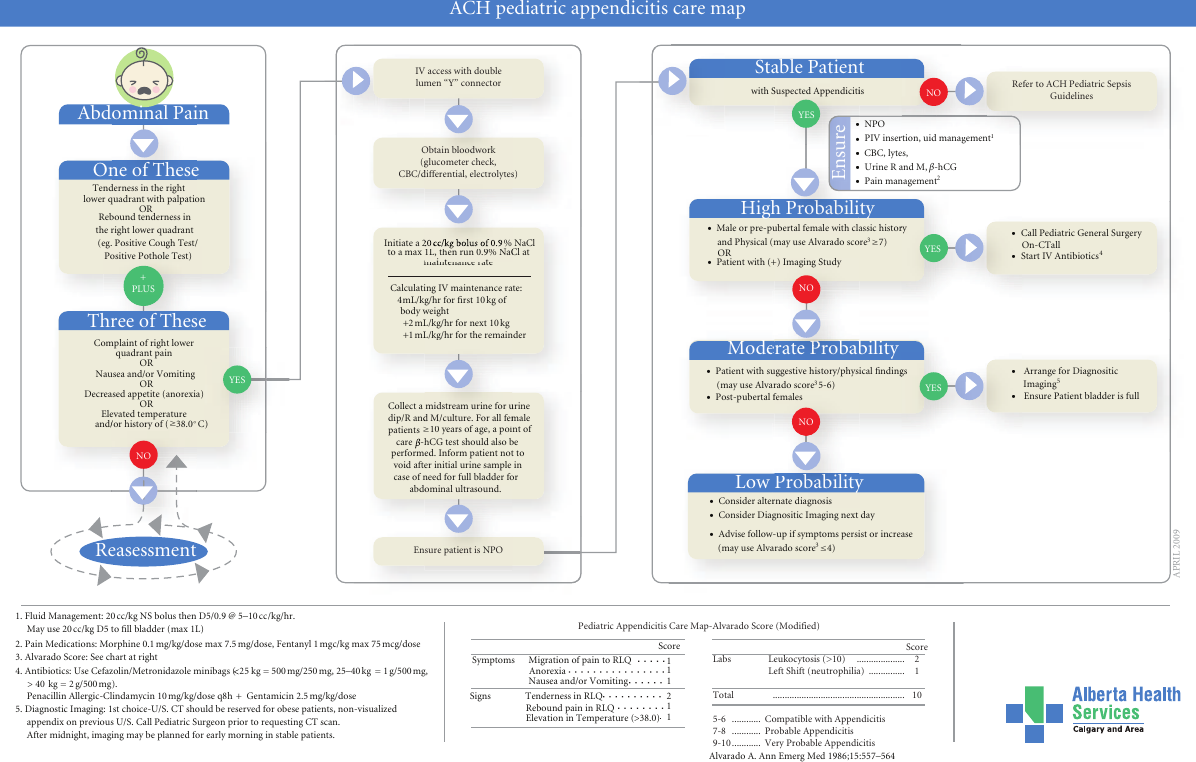
Figure 5: The Alberta Children’s Hospital Appendicitis Care Map. Note the use of Alvarado Score criteria in the AND to guide initiation of IV fluids, laboratory investigations, and preparation for potential